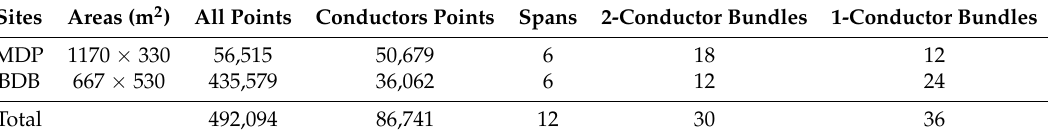
Table 4. Summary of the ground